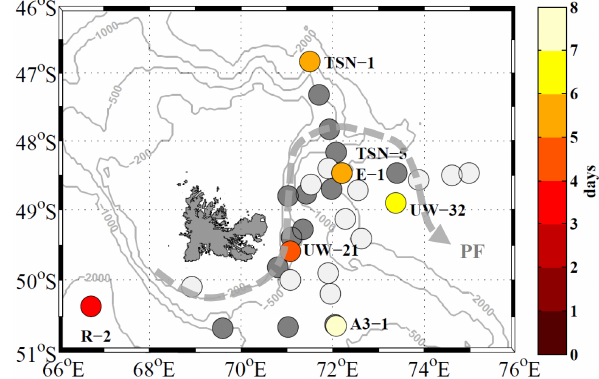
Figure 8. Apparent ages of surface waters determined using the 224 Ra/ 223 Ra ratios. The offshore apparent ages were estimated us- ing an initial 224 Ra/ 223 Ra ratio that was obtained by averaging the ratios found at stations located on the northern Kerguelen Plateau (<200m water depth). When both 224 Ra and 223 Ra were signif- icant, apparent ages could be determined (colored symbols). The samples displaying an apparent age between 1 and 2 months are shown in dark gray ( 224 Ra<DL but significant 223 Ra activities). Water samples displaying an apparent age >2 months are shown in light gray ( 224 Ra<DL and 223 Ra<DL). A schematic view of the polar front (PF) is